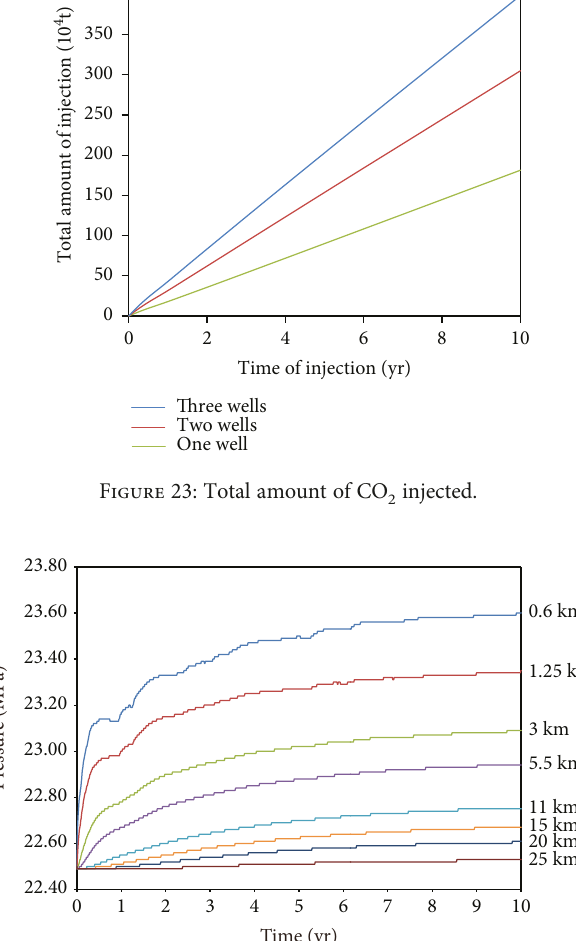
Figure 24: Pressure changes at the pressure monitoring points during injection in the 1-well